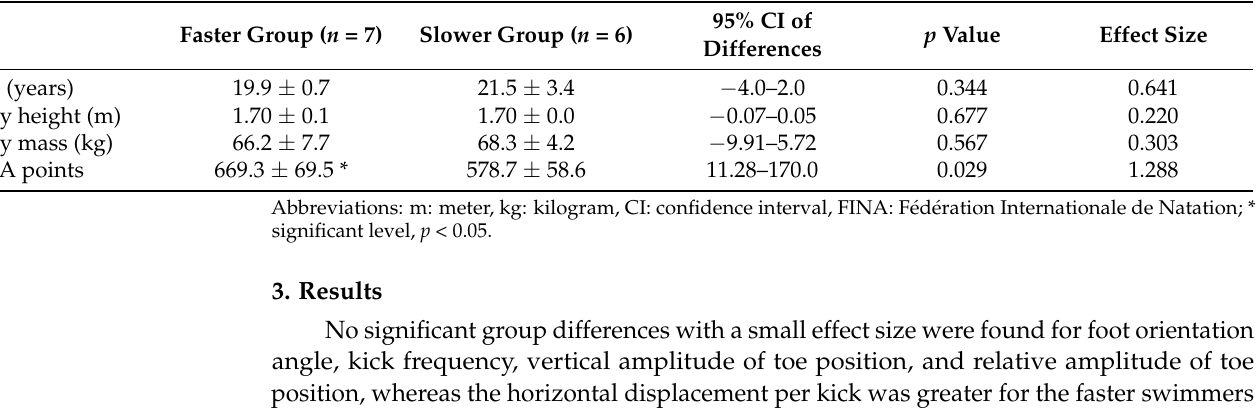
Table 1. The basic data of the participants.